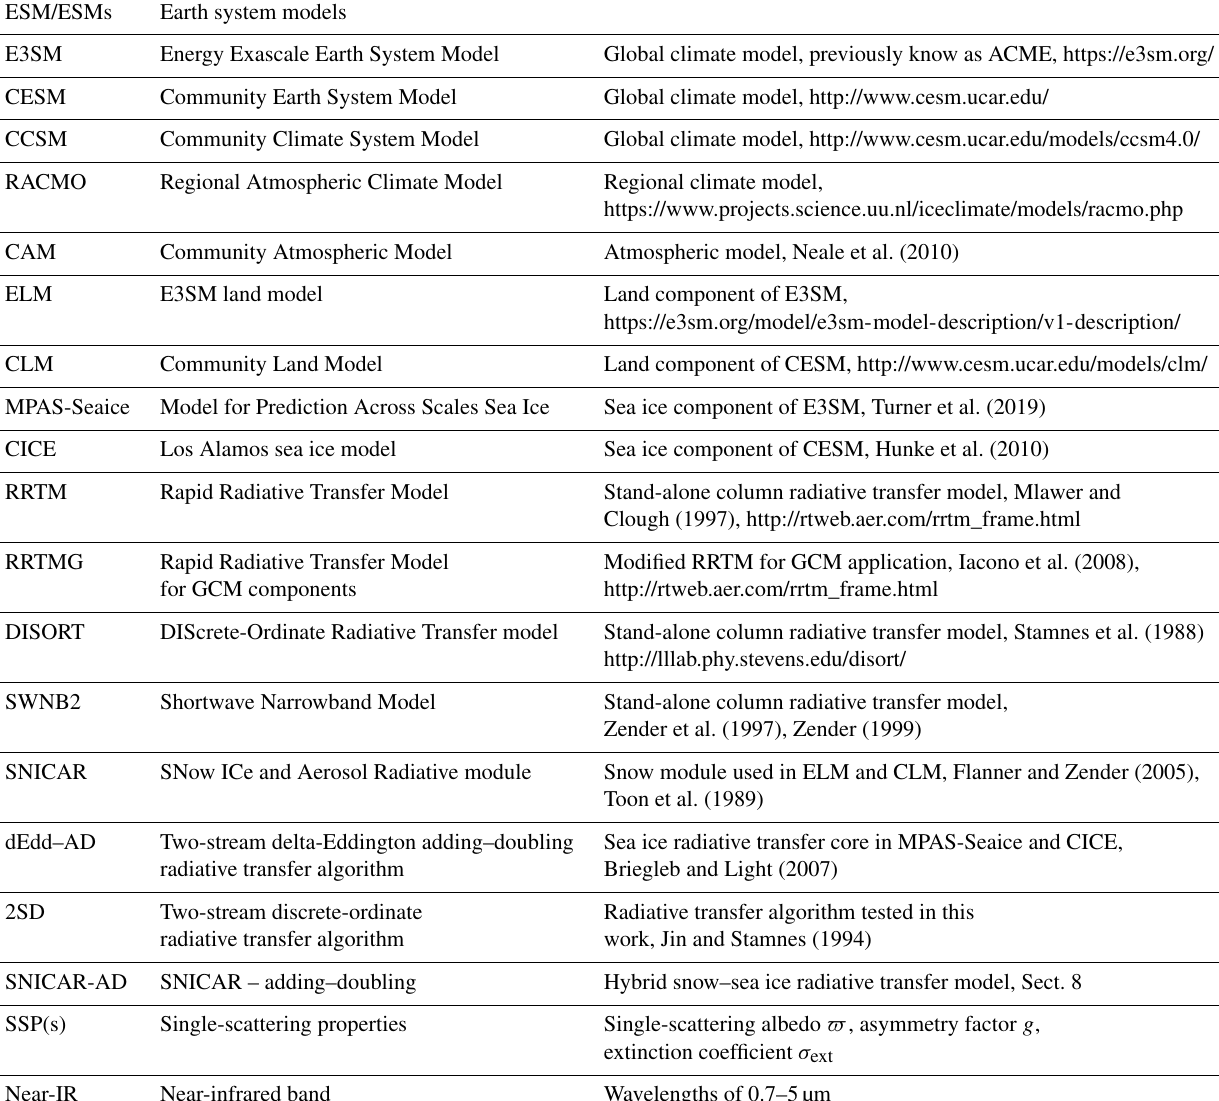
Table 1. Abbreviations used in this paper and their references. Last access date for all cited URLs in this table is 22 July 2019.